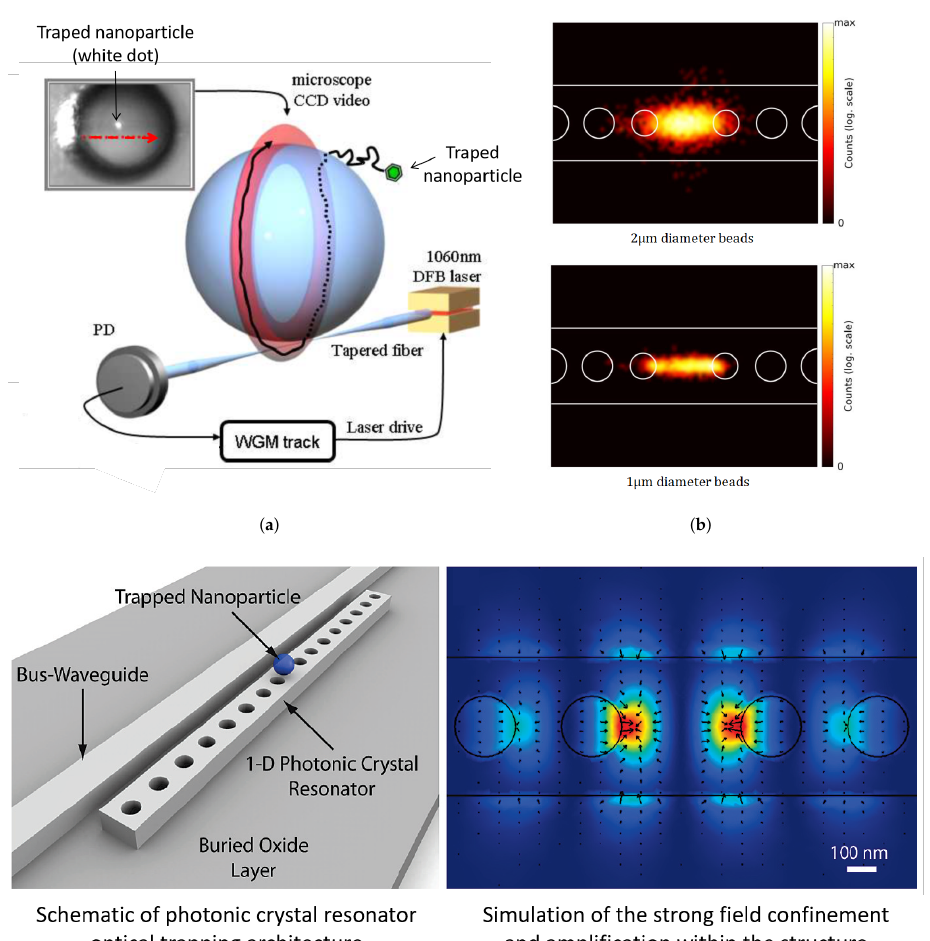
Figure 13. Examples of resonant cavity traps: ( a ) Nanoparticle navigating in the direction that light takes within the WGM. The red arrow represents the light path in the cavity. Adapted with permission from [87] © The Optical Society. ( b ) A count of particles position in a photonic crystal resonator for different bead diameter. Adapted with permission from [89]. Copyright (2015) American Chemical Society. and ( c ) photonic crystal resonators architecture and field confinement. Adapted with permission from [81]. Copyright (2010) American Chemical